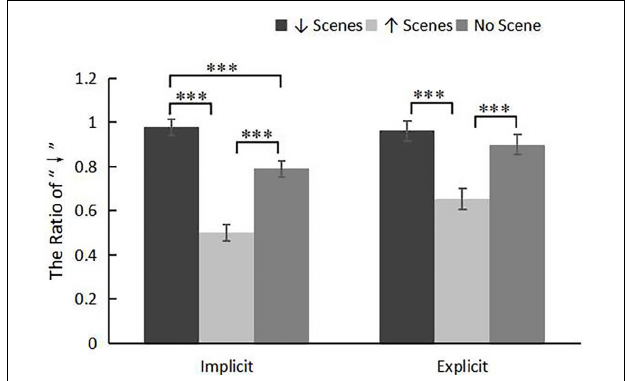
FIGURE 3 | Results from Experiment 2: mean ration of “ ↓ ” as a function of task type in downward priming (black bars), upward priming (light gray bars) and none priming conditions (dark gray bars).The Error bars represent the standard errors for each condition. *** p <